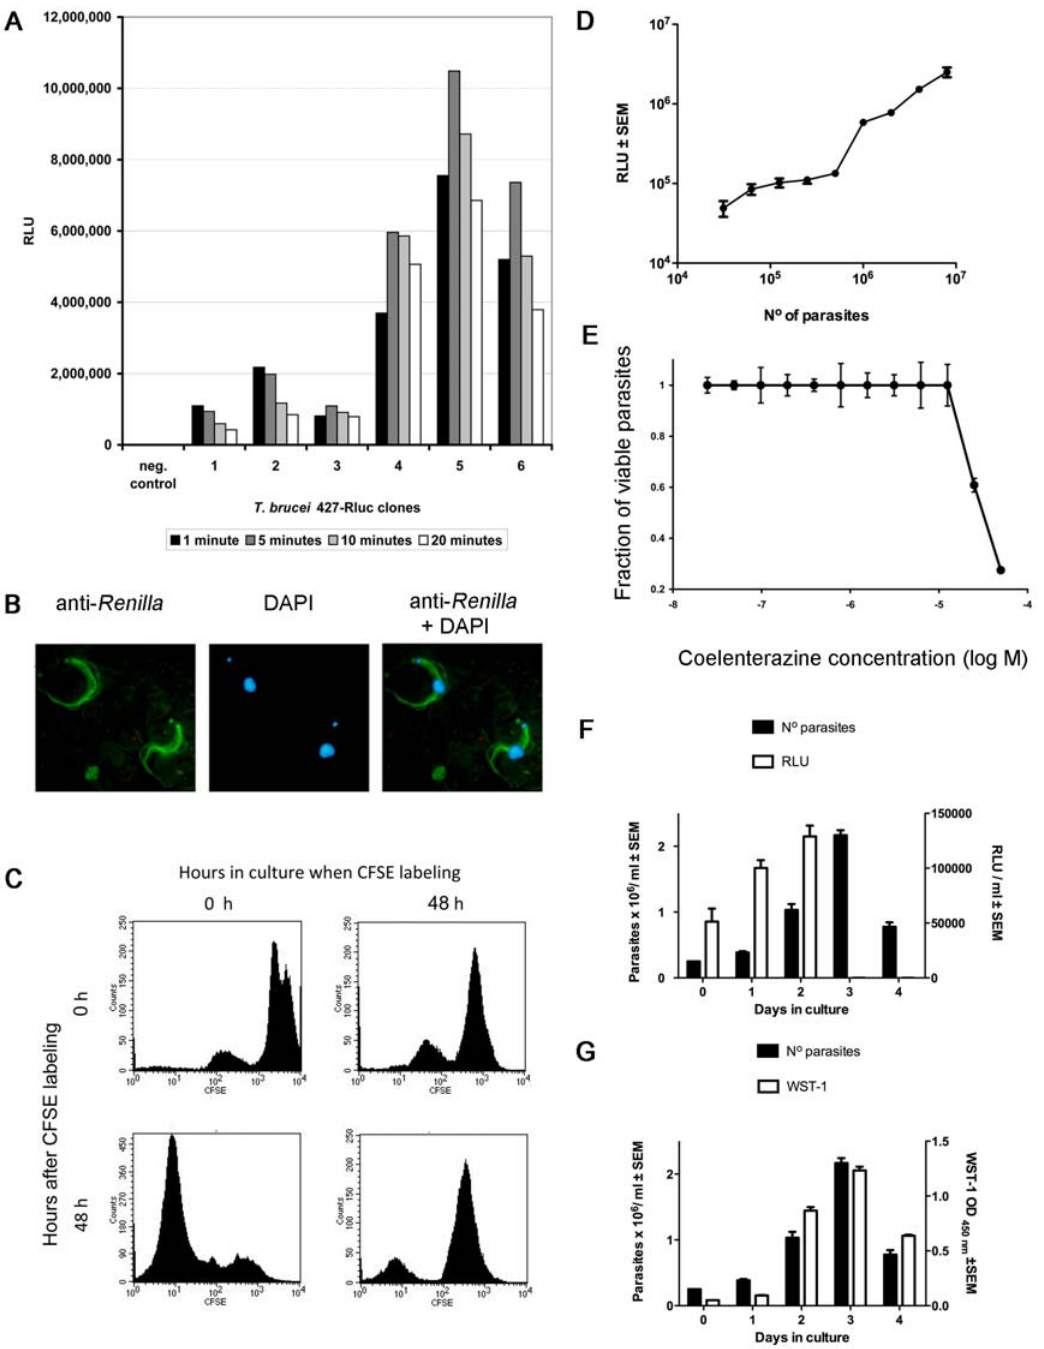
Figure 1. Invitro bioluminescence, uptake of substrate and light emission of live cells. A. In vitro activity of 6 clones of T.b. brucei 427-Rluc expressing the Renilla luciferase is shown at different time points after substrate addition. Clones 1–3 and 4–6 were selected from two independent electroporation events. Efficiency of Renilla luciferase expression in clones 1–3 is lower than clones 4–6, yet resulting in a detectable signal. Clone 4 was selected for further in vivo work, showing a high RLU signal slowly decreasing over time. Negative control corresponds to non-transformed T.b. brucei 427. B. Correlation between parasite concentration and RLU activity. Different concentrations of Rluc transfected T.b. brucei Lister 427 were incubated with coelenterazine and RLU of triplicate wells measured after 5 minutes incubation. C. Expression and localization of Renilla luciferase in T. brucei AnTat 1.1E. Anti-Renilla FITC staining (left), DAPI staining (middle) and overlay (right). Magnification: 60 6 . D. T.b. brucei Lister 427 was incubated for 72 h with different concentrations of coelenterazine and the viability of triplicate cultures of the parasites was determined by WST-1 assay in relation to untreated parasites. The arrow indicates the final concentration of coelenterazine used in vivo . E. Luciferase activity in different life stages of T. b. brucei AnTat1.1 E . Parasites were labeled with CFSE at 0 or 48 h after initiation of the culture. At 0 or 48 h after labeling cells parasites were fixed and CFSE dilution in daughter cells was analysed by FACS. F, G. T. b. brucei AnTat1.1 E density, WST-1 assay and RLU were measured in triplicate at the indicated time points culture of (2.5 6 10 4 )